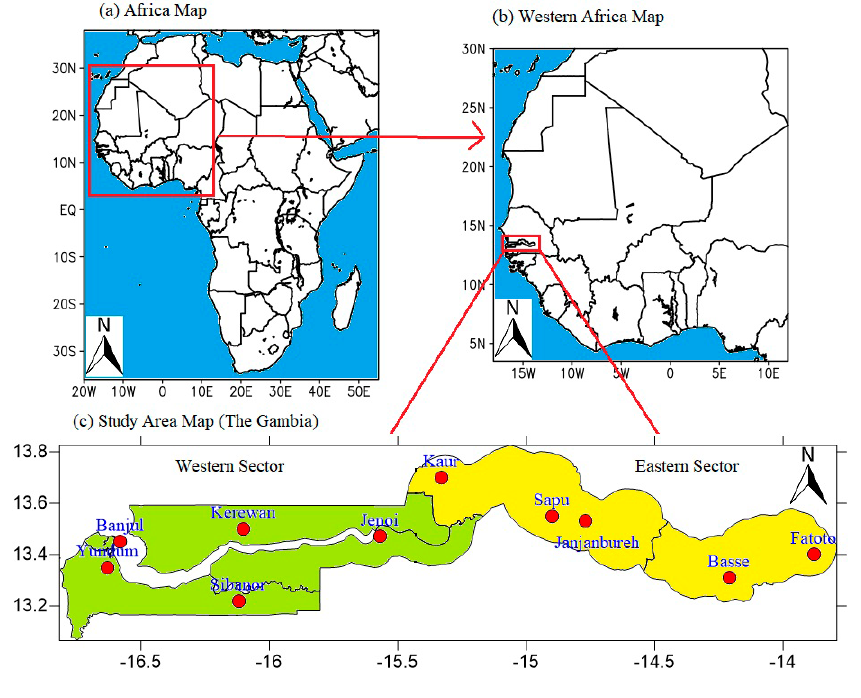
Figure 1. The Geographical location of (a) Western Africa on the map of Africa (red rectangle), (b) The Gambia in Western Africa (red rectangle), (c) the study area showing meteorological stations (red dot), eastern sector (yellow shade), and western sector (green